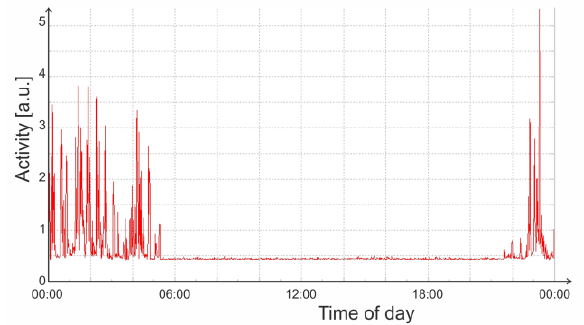
Figure 3. Output from biosensor shown in Figure 2 represent records in image differences quantifying pest activity during the day, indicating a nocturnal peak activity of the pest.